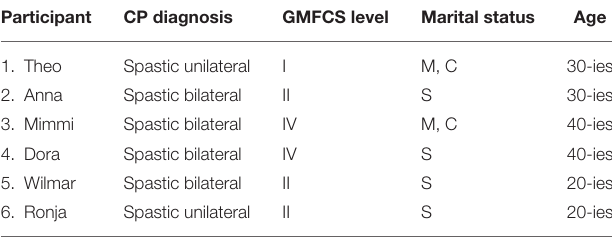
TABLE 2 | Participant